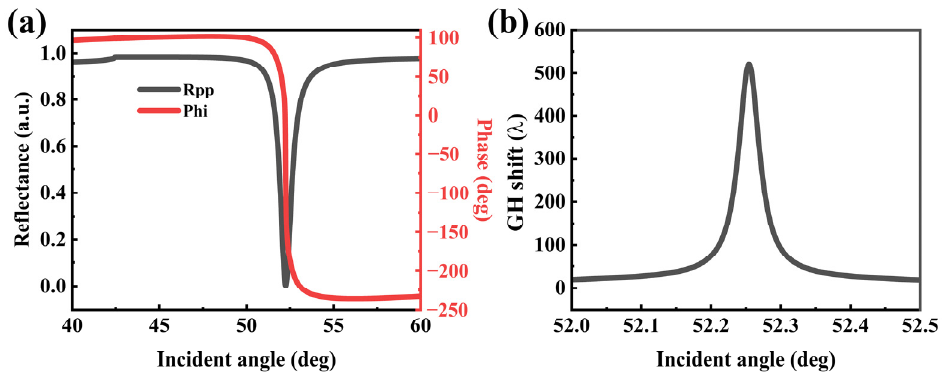
Figure 3. Variation in the ( a ) reflectance and phase, ( b ) GH shift for 350 nm DSM film with respect to the incident angle when E f = 0.5 eV, respectively. The other parameters of the DSM are the same as for Figure 2.